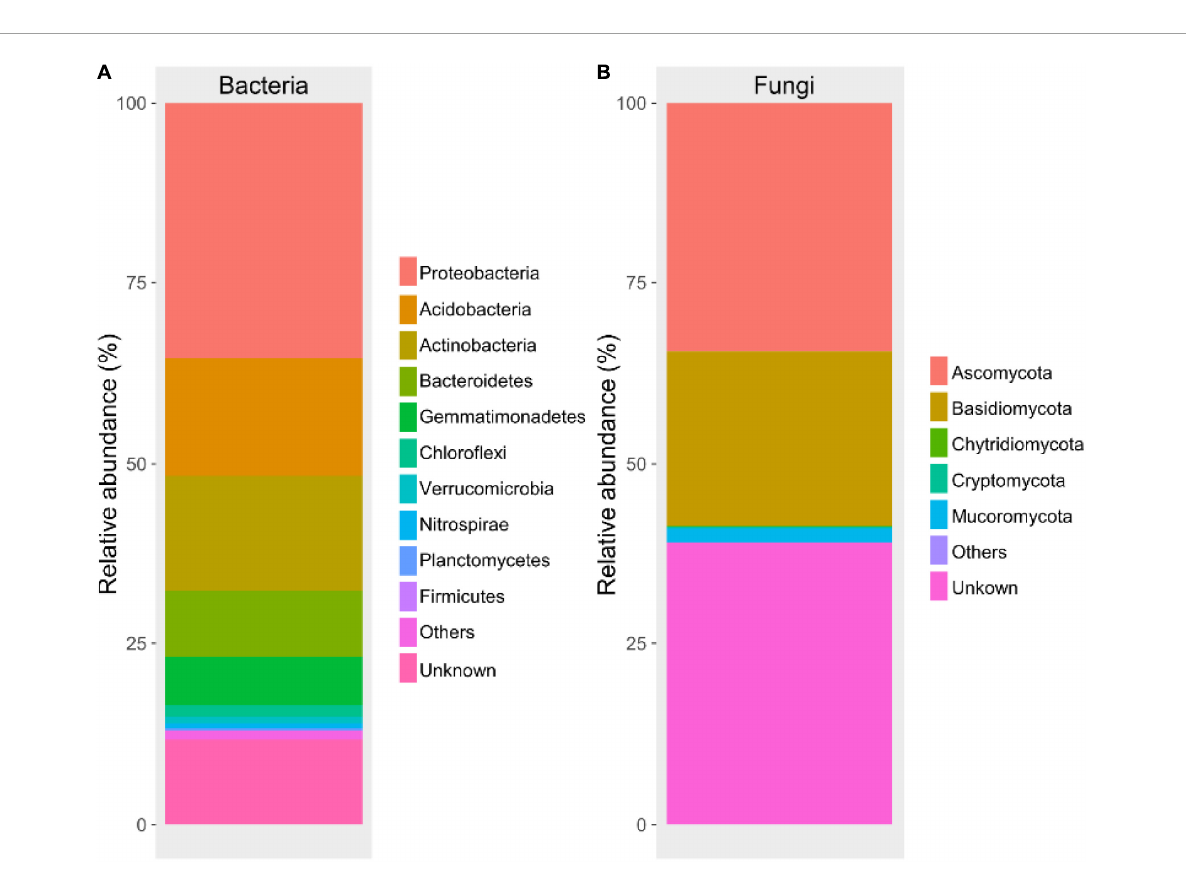
FIGURE2 Relative abundances (%, proportion of sequencing reads) of bacteria (A) and fungi (B) at the phylum level in this